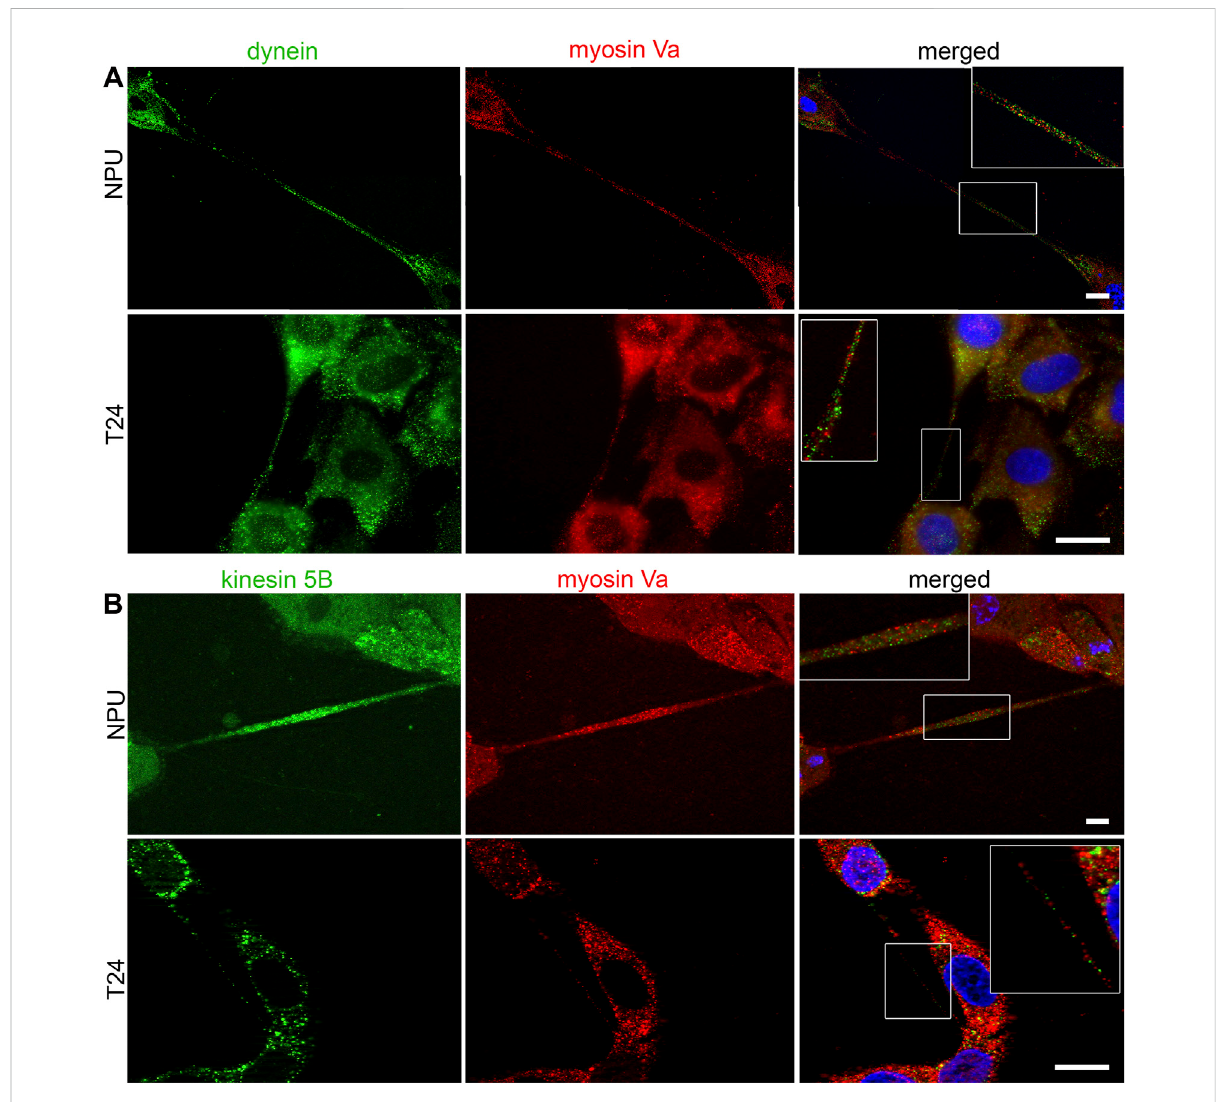
FIGURE 6 Co-distribution of motor proteinsinTNTs ofnormal(NPU) and cancer (T24) urothelial cells. The pairs of motor proteins dynein-myosin (A) and kinesin-myosin (B) in NPU and T24 cells. The insets on the merged images are enlarged in the corners. The nuclei are stained with DAPI. Scale bars: 20 μ